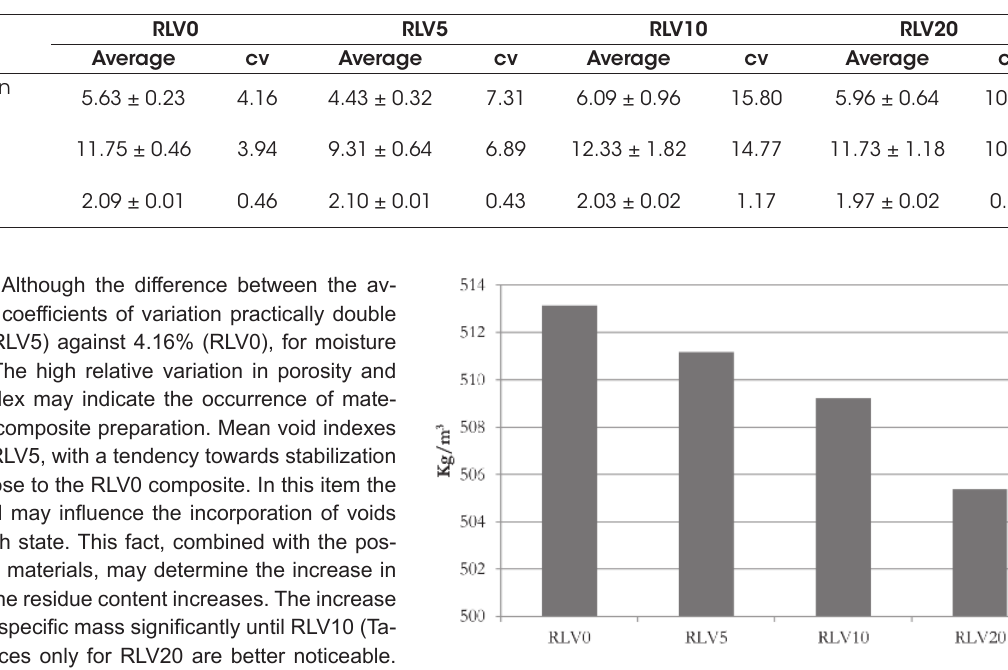
Physical characteristics of hardened composites determined by immersion in water. CV = coefficient of